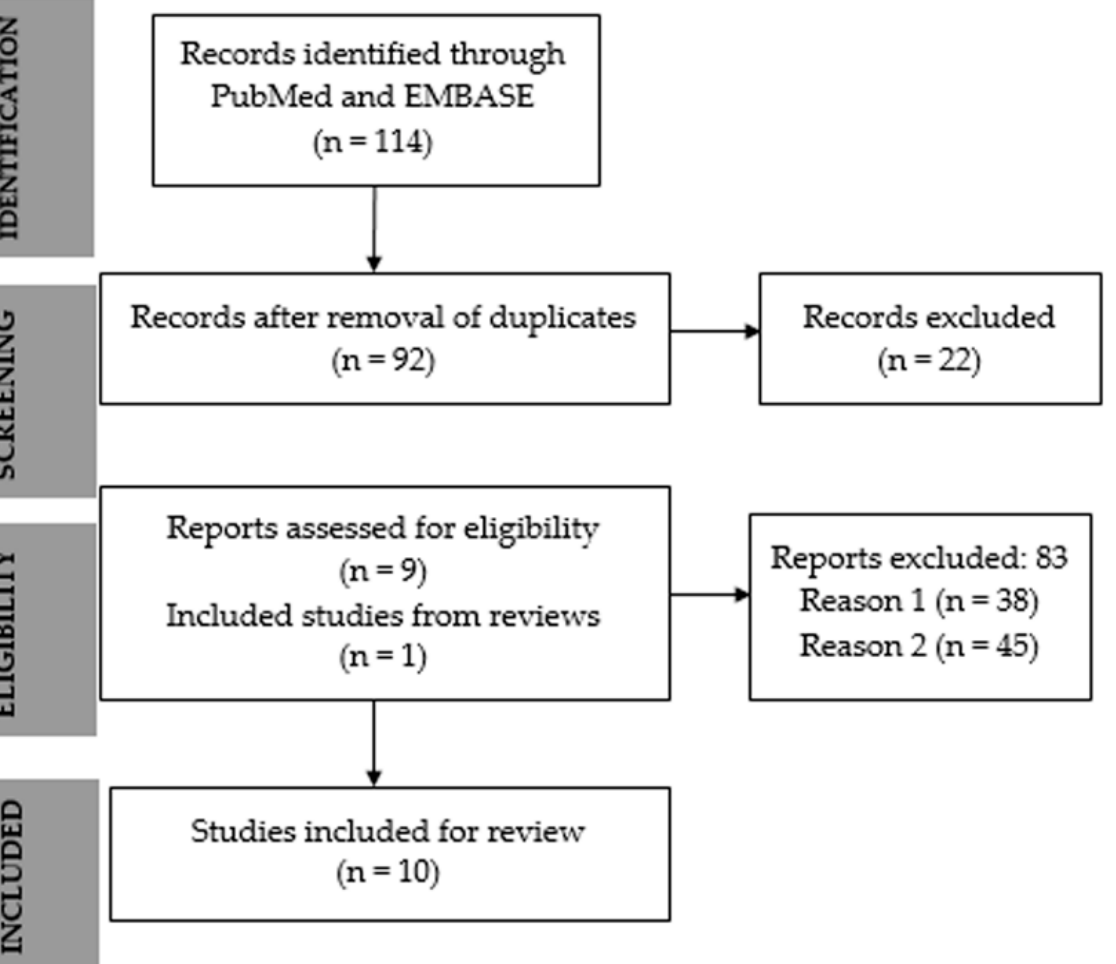
Figure 1. Flowchart of search strategy and selection. Reason 1: type of article; Reason 2: content out of revision topic.